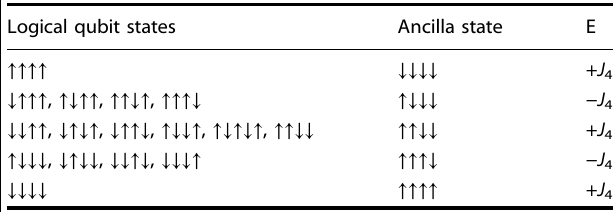
Table 1. Illustration of the various states of the four-body term